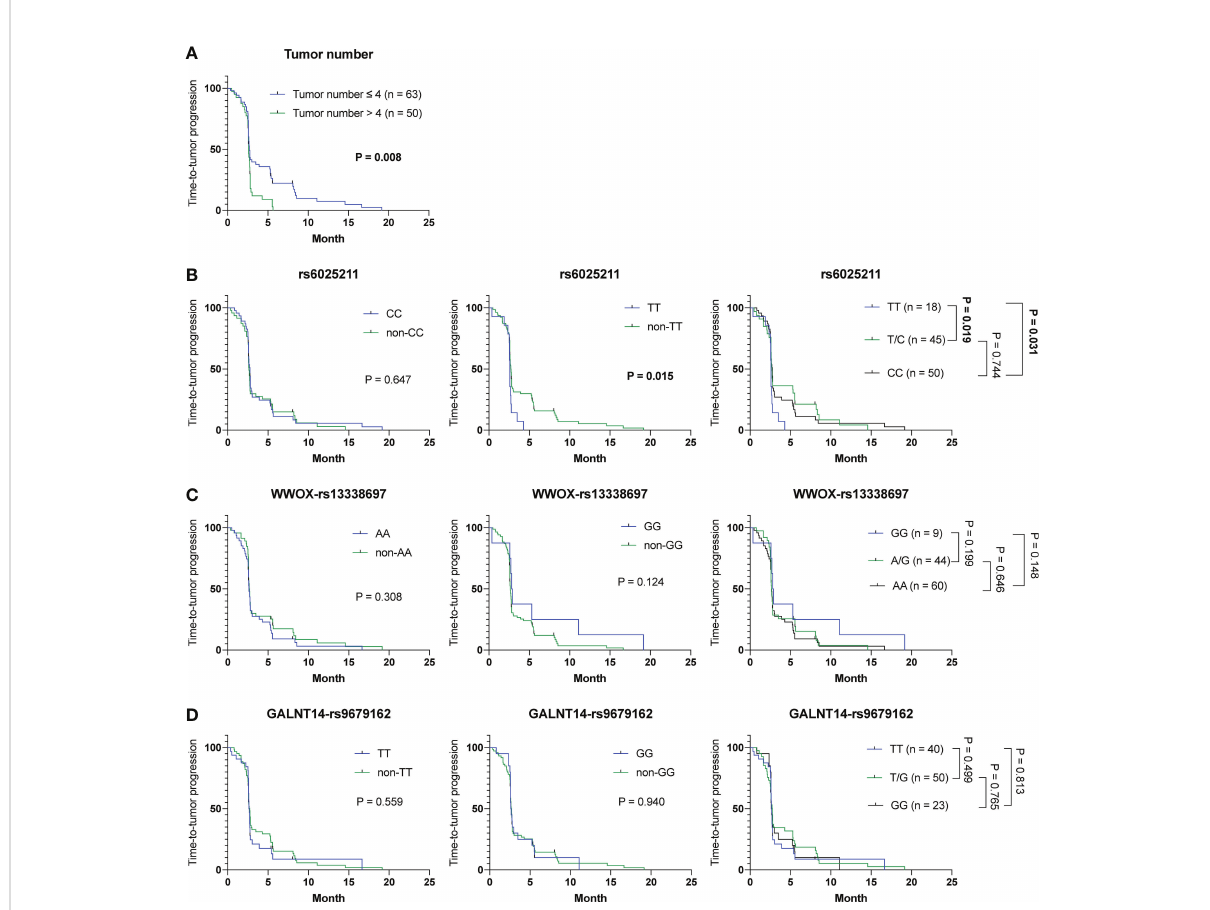
FIGURE 2 Analysis of clinicopathological factors and SNP genotypes in association with TTP in HCC patients treated with ADI-PEG 20 monotherapy. Kaplan-Meier analysis of subgroups of patients with HCC strati fi ed by (A) tumor number, (B) rs6025211, (C) WWOX -rs13338697, and (D) GALNT14 -rs9679162 genotypes. P values were obtained by log-rank test, and < 0.05 was considered signi fi